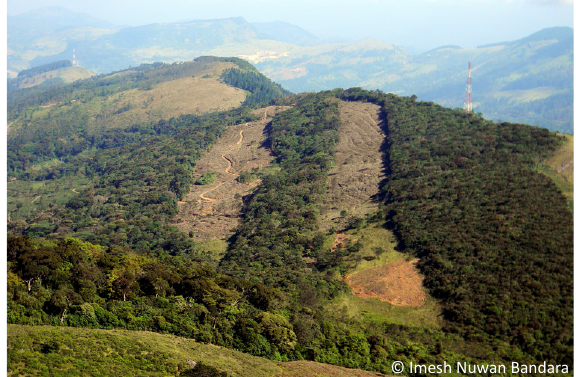
Image 10. The forest fragmentation spread over a large area of the Loolkandura, threatened habitat.